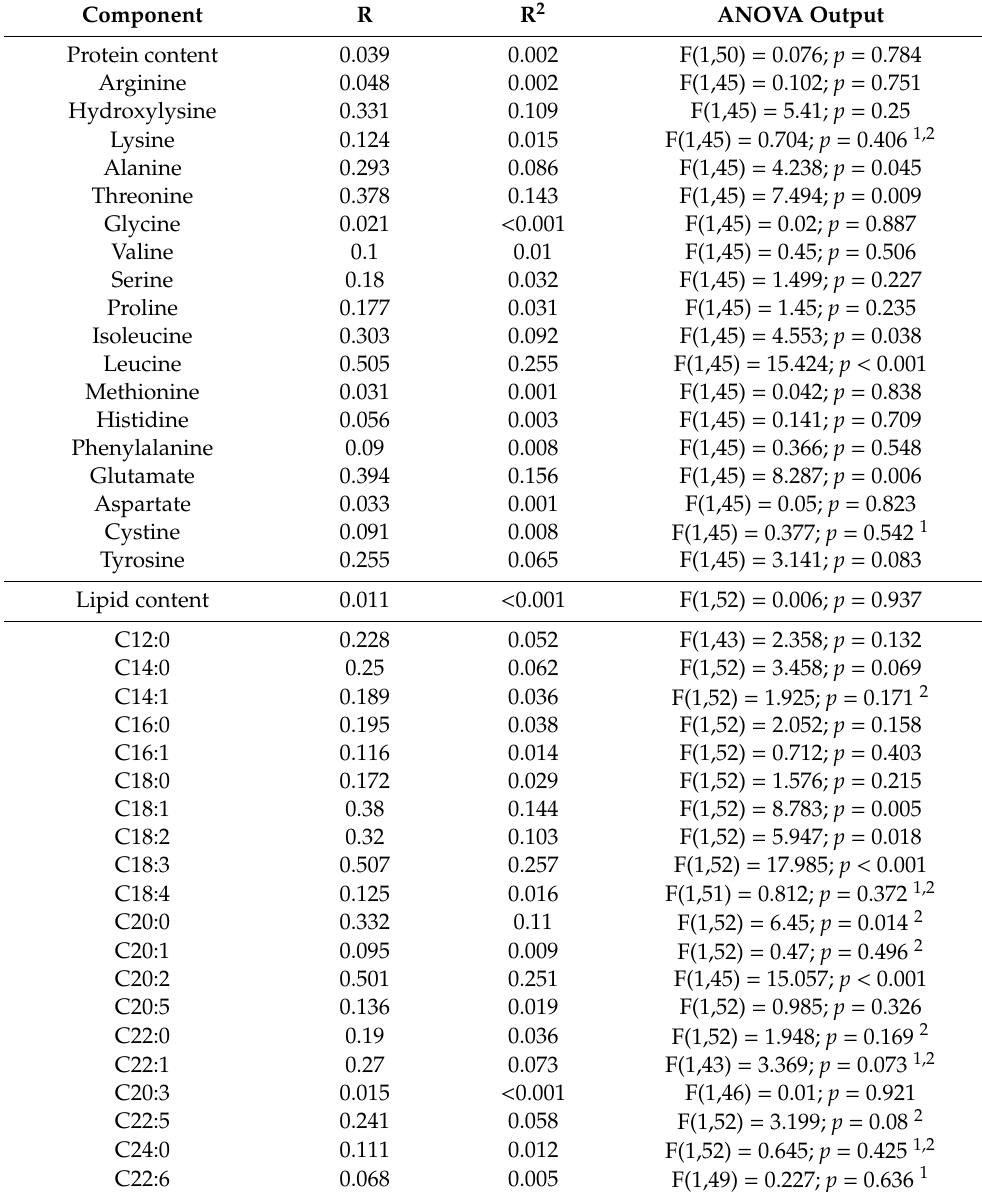
Table 2. Results of the simple linear regression analysis between the composition of the diet and the